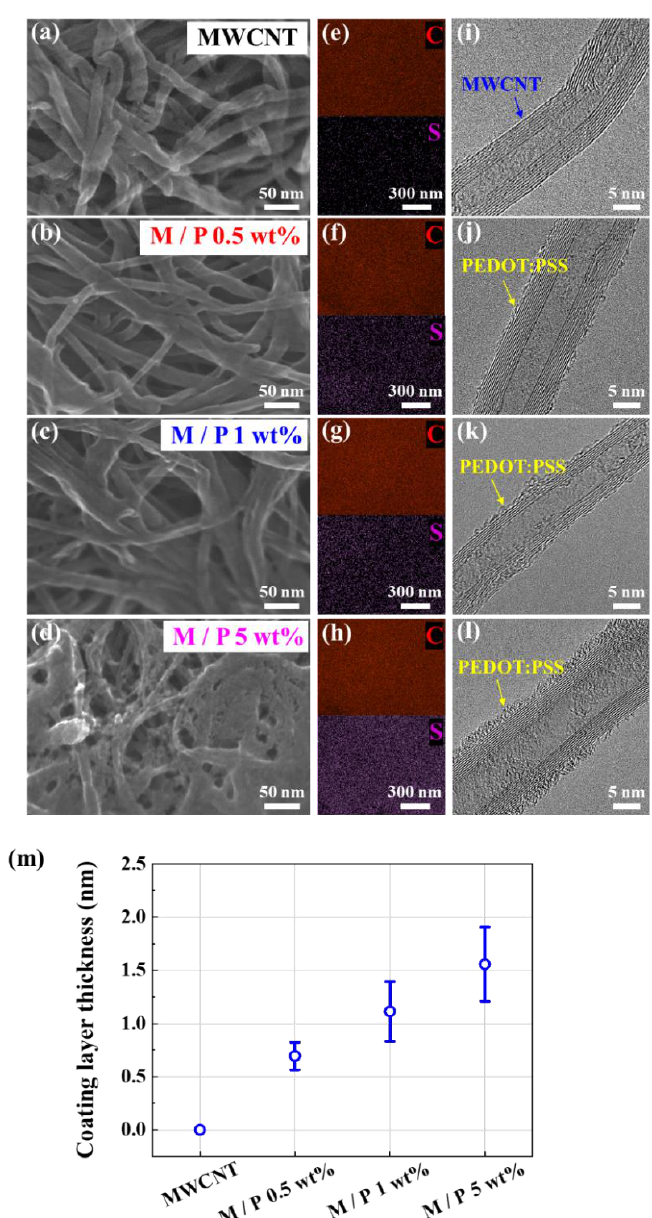
Figure 3. SEM images of ( a ) pristine MWCNTs and MWCNTs coated with ( b ) 0.5 wt% PEDOT-PSS, ( c ) 1 wt% PEDOT-PSS, and ( d ) 5 wt% PEDOT-PSS. EDS mapping for ( e ) pristine MWCNTs and MWCNTs coated with ( f ) 0.5 wt% PEDOT-PSS, ( g ) 1 wt% PEDOT-PSS, and ( h ) 5 wt% PEDOT-PSS. TEM images of ( i ) pristine MWCNTs and MWCNTs coated with ( j ) 0.5 wt% PEDOT-PSS, ( k ) 1 wt% PEDOT-PSS, and ( l ) 5 wt% PEDOT-PSS. ( m ) a coating layer thickness of PEDOT:PSS on the outer